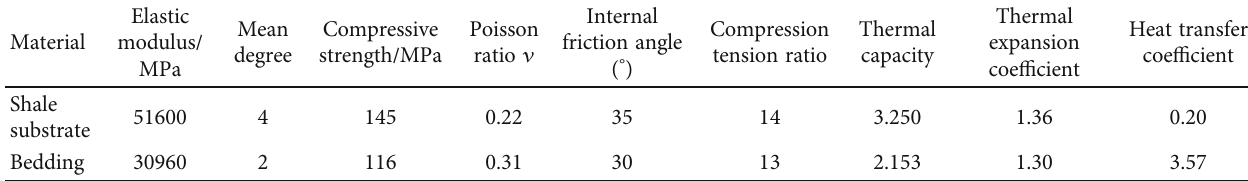
Figure 4: Stress-strain curves of di ff erent bedding inclination angles at (a) 30 ° C, (b) 60 ° C, and (c) 90 ° C. Table 1: Numerical simulation parameters